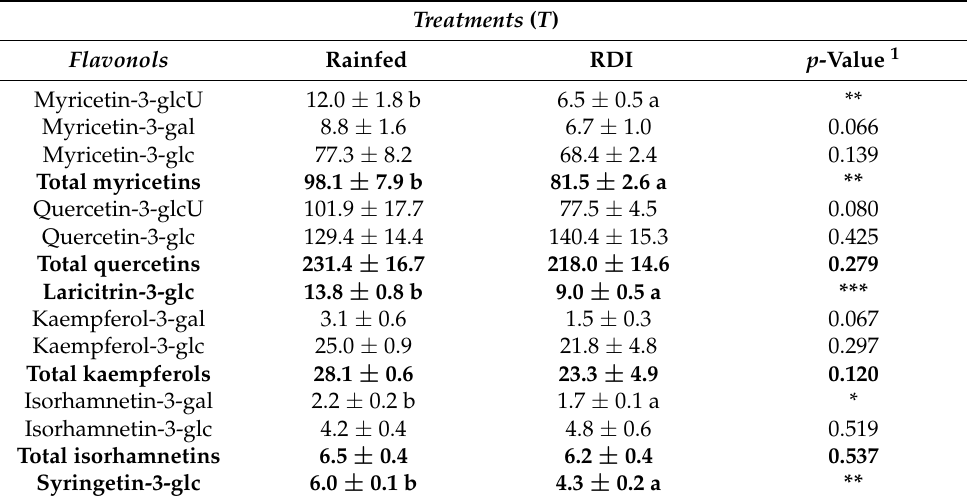
Table 2. Flavonol content (mg/kg) in Monastrell grapes from grapevines under non-irrigated (rainfed) and regulated deficit irrigation (RDI) conditions.